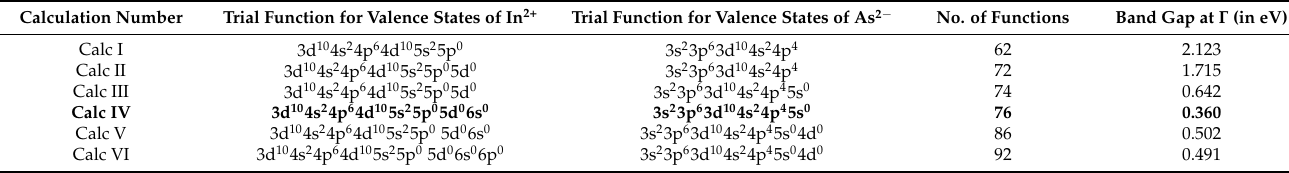
Table 2. The successive, self-consistent calculations of the BZW method for zb-InAs. The calculation corresponding to the optimal basis set is in